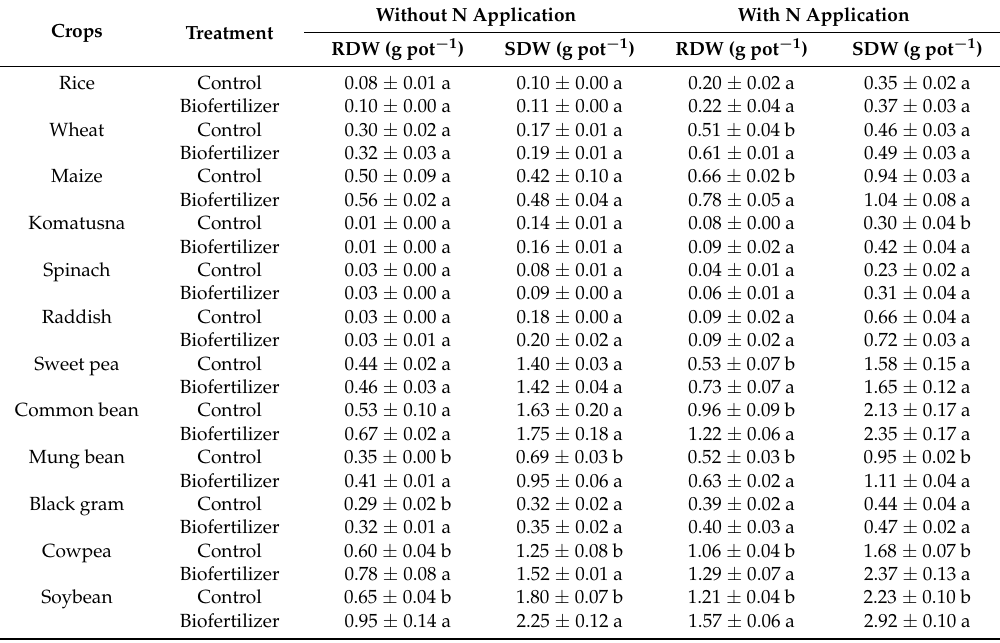
Table 1. Effect of biofertilizer on RDW and SDW (g pot − 1 ) of various crops with or without nitrogen application.